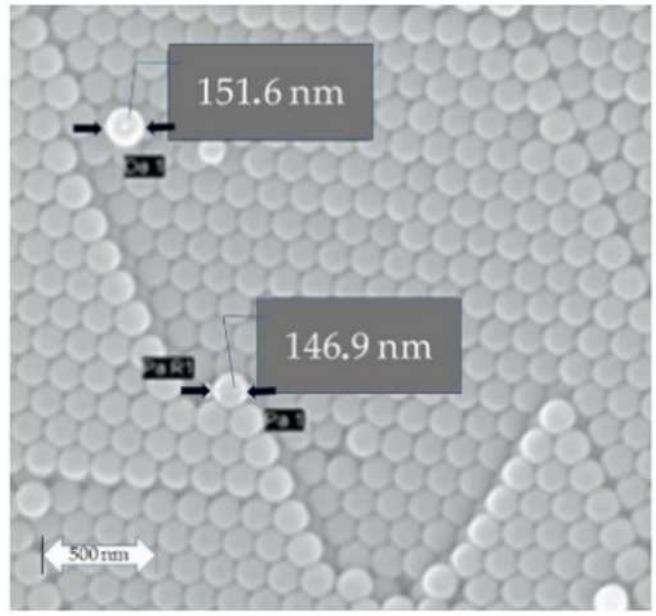
Figure 1. SEM micrograph of polystyrene nanospheres produced under the conditions of Table